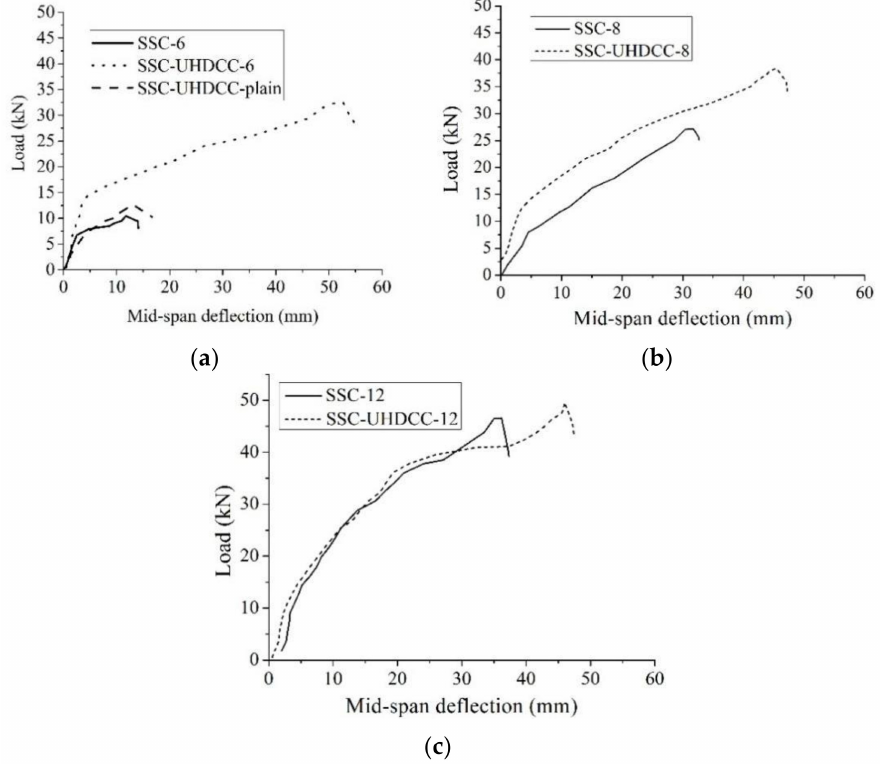
Figure 12. Load vs. displacement curve: ( a ) SSC-6 vs. SSC-UHDCC-6 vs. SSC-UHDCC-plain; ( b ) SSC-8 vs. SSC-UHDCC-; and ( c ) SSC-12 vs.